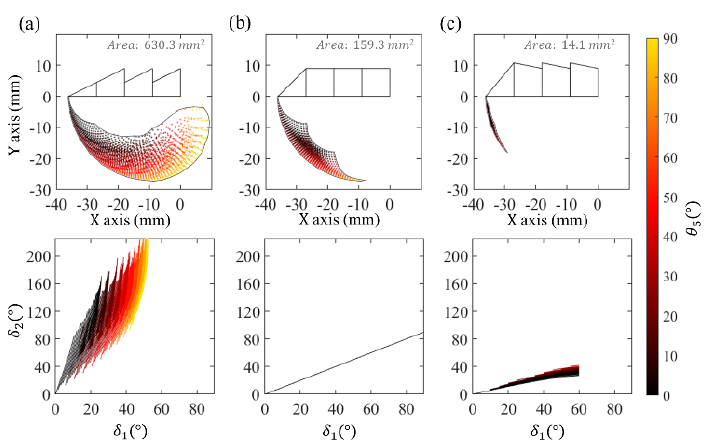
Figure 13. Scatter plots ( top ) and input – output angle relationships ( bottom ) of the triple four-bar linkage structures when h 1 = 1.0 L with length ratios ( a ) R = 0.5, ( b ) R = 1.0, and ( c ) R = 1.2.